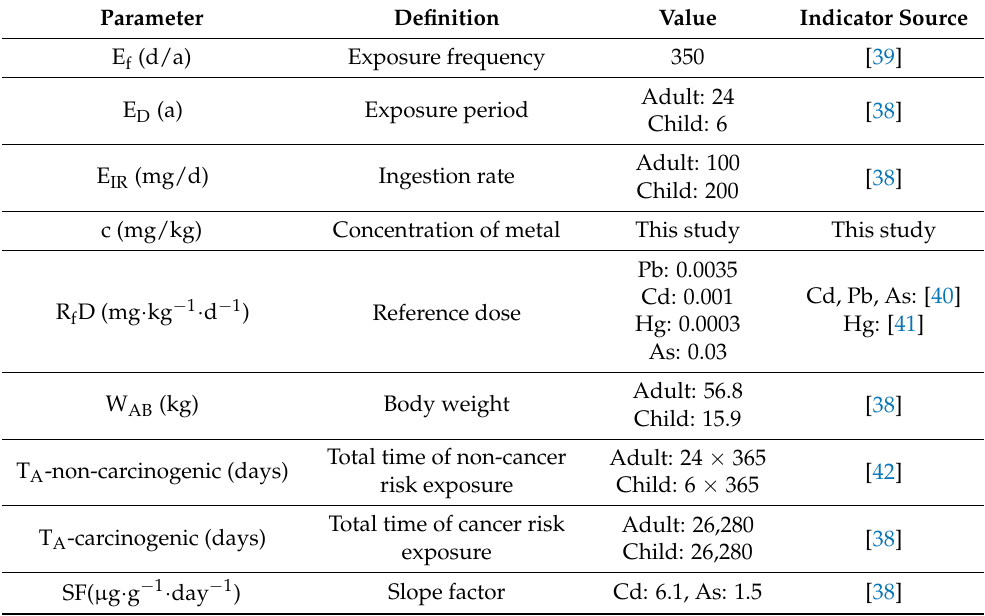
Table 3. Parameters related to metal health